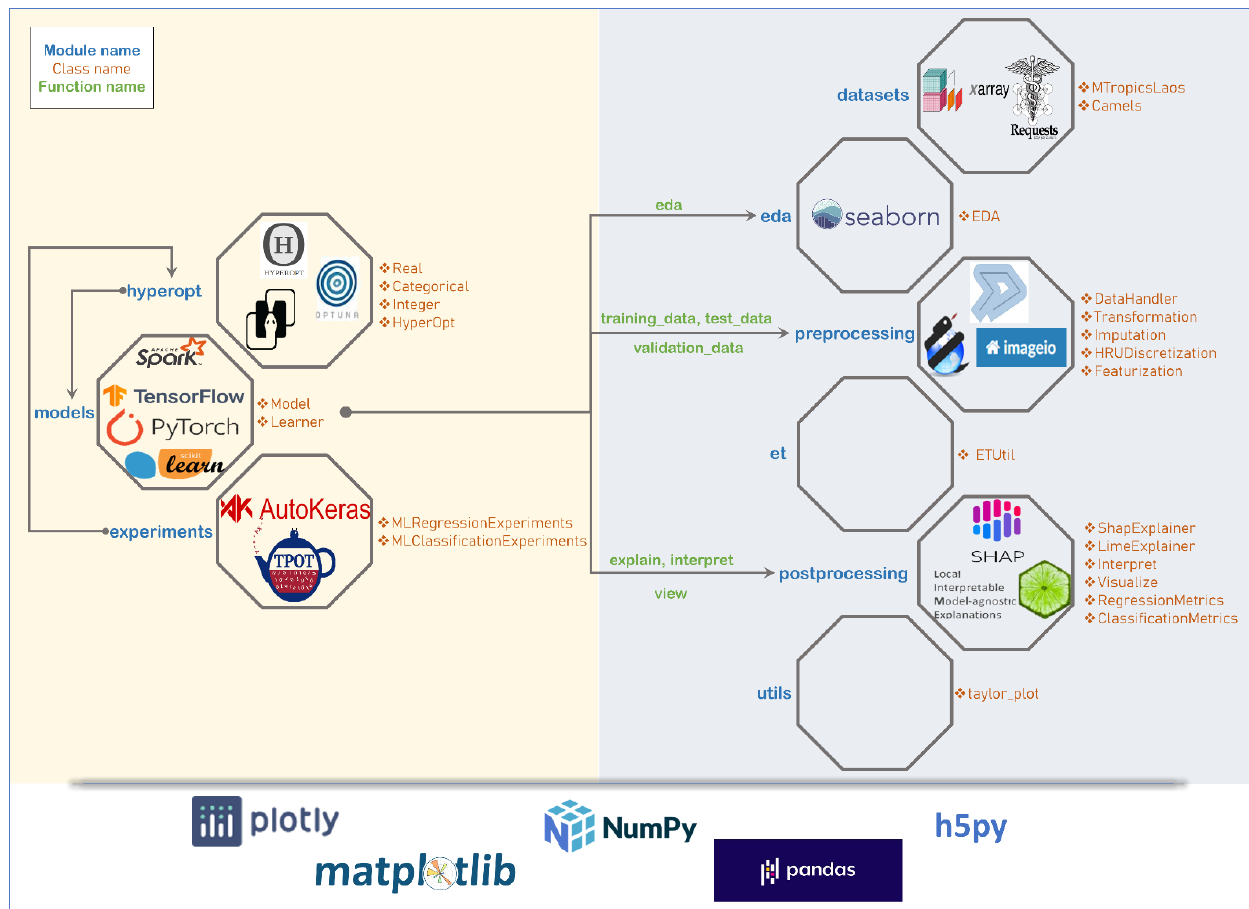
Figure 3. Framework architecture, sub-modules, classes, and third-party libraries used by AI4Water. Each box represents a sub-module. The names of classes in each sub-module are written along with the corresponding box. The third-party libraries upon which the sub-module depends are written inside the box. Empty boxes show that these sub-modules do not depend on a specific third-party library. The five generic libraries written at the bottom are used in all sub-modules. Arrows represent the caller sub-module and the sub-module being called. The sub-modules on the right-hand side are related to pre-processing and post-processing. The Model class interacts with pre-processing and post-processing sub-modules using its methods which are written in the green